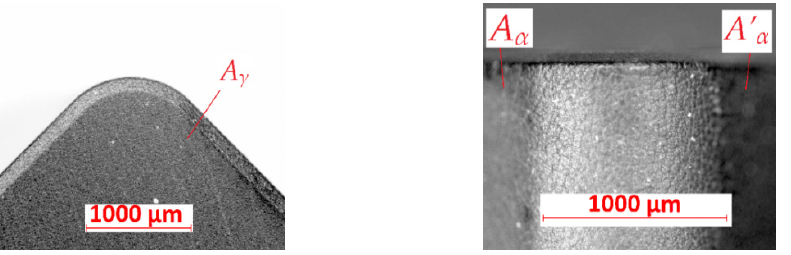
Figure 5. View of measurement areas for cutting inserts KENNAMETAL SNGN 120408 T01020 KYS25 before turning: A γ —rake surface, A α —principal flank surface, A’ α —auxiliary flank surface.